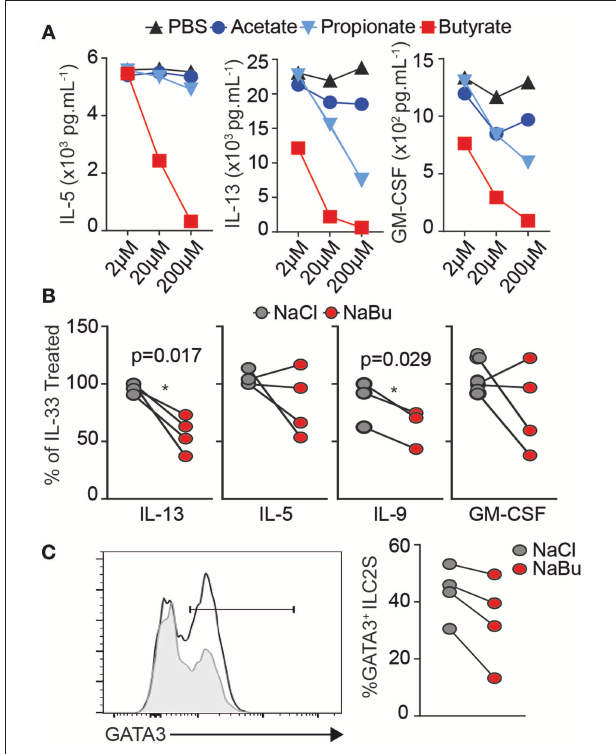
FIGURE 4 | Human ILC2 are suppressed by Butyrate treatment. Human ILC2s were FACS purified (Live Lin − CD45 + CD161 + CD127 + CRTh2 + ) from healthy human PBMCs and cultured ex-vivo for 5 days in the presence of 10ng/mL rhIL-2, rhIL-7, and 30ng/mL rhIL-33 with Sodium Chloride or Sodium Butyrate (10 uM unless indicated), at 5 × 10 3 cells/well. (A) Dose titration and cytokine production in culture supernatant by Luminex assay, n = 2 donors. (B,C) Data are represented as percent of untreated controls, representative of four independent donors. (C) Intracellular GATA3 expression by flow cytometry in Acetate-treated (line) and butyrate (gray fill). Data representative of n = 6 independent donors * p < 0.05 using paired T